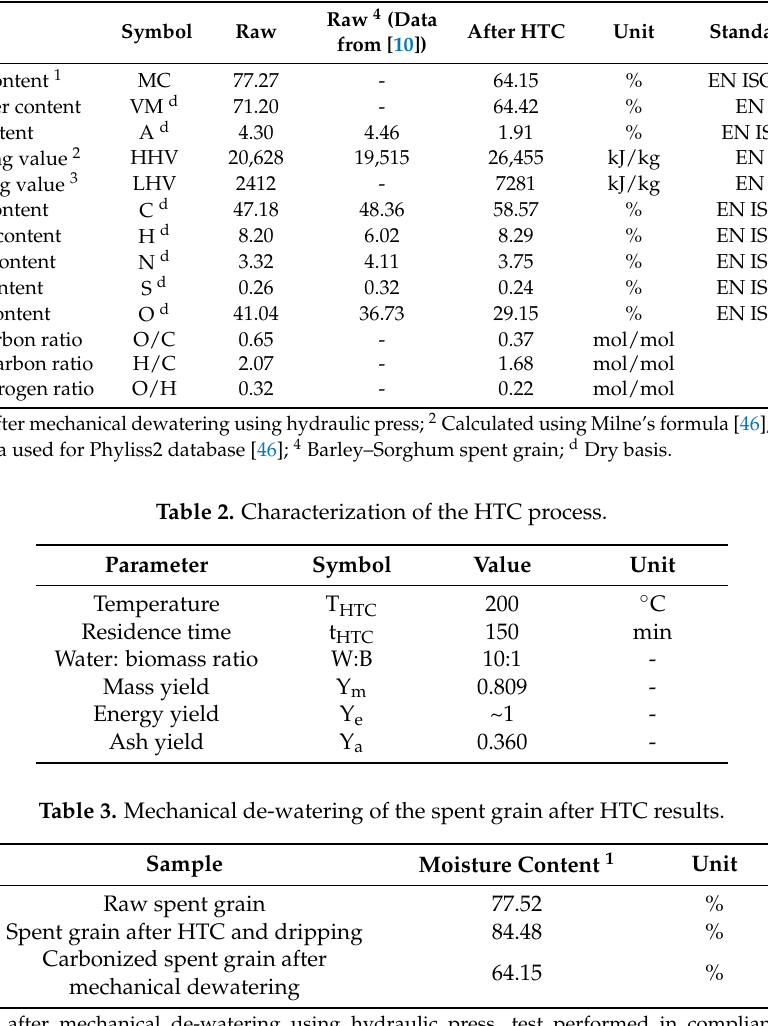
Table 1. Proximate and ultimate analysis of raw and hydrothermally carbonized spent.